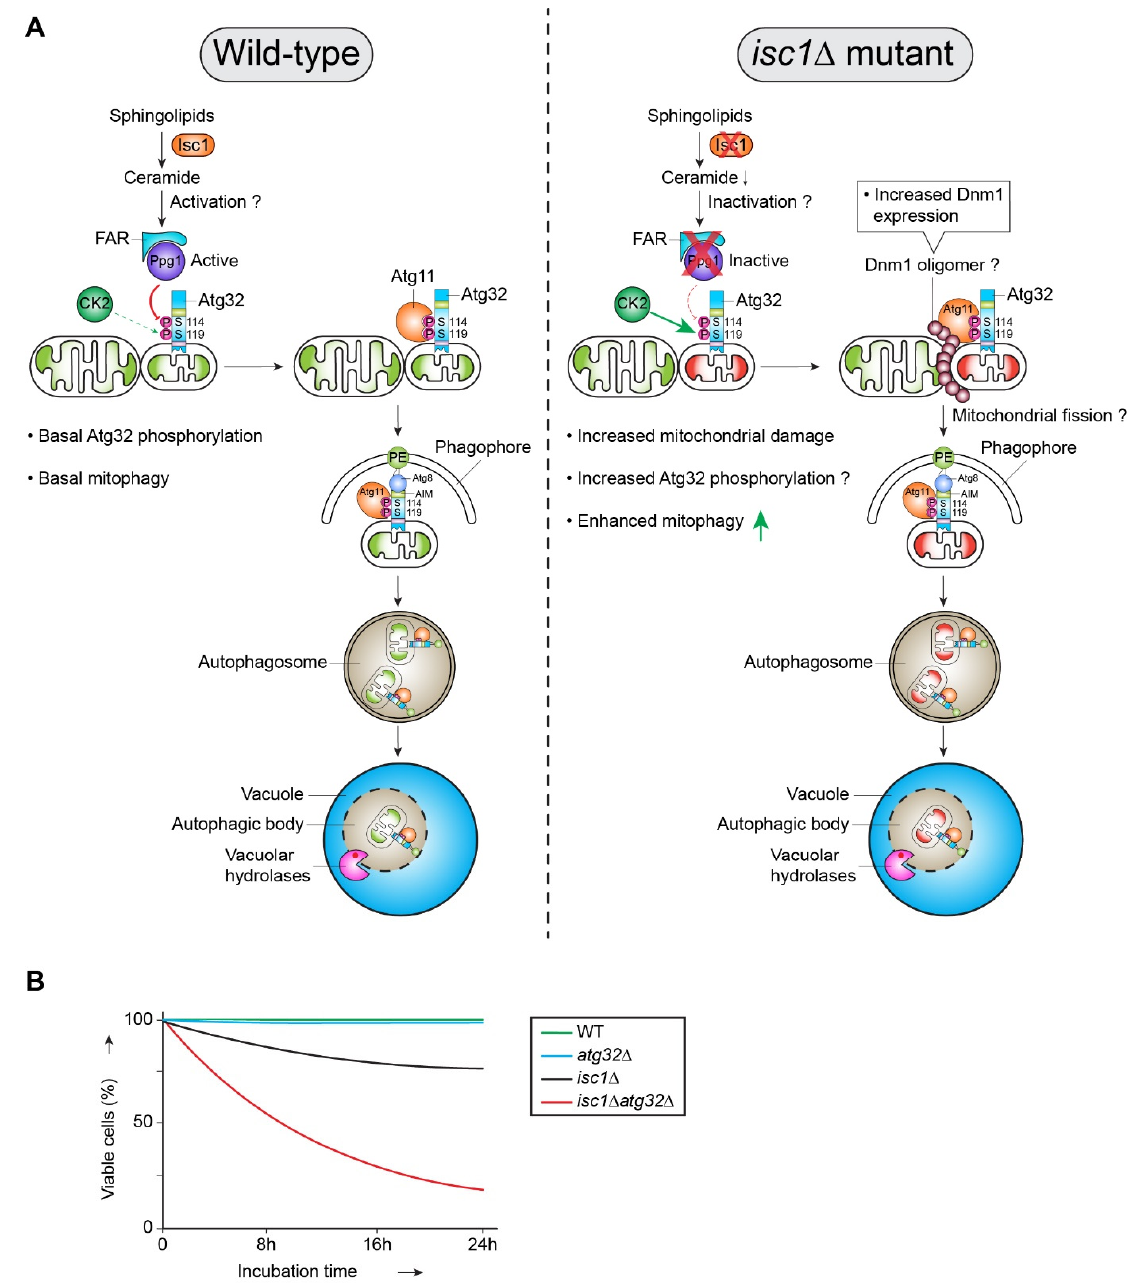
Figure 3. Interplay of ceramide synthesis, mitochondrial damage, and mitophagy in baker’s yeast. ( A ) . Regulation of Atg32-dependent mitophagy in the wild type (WT) and isc1 ∆ mutant strains. S. cerevisiae WT cells, when grown over time on non-fermentable carbon sources, maintain a basal level of mitophagy limiting excessive mitophagy. This apparently depends on the recruitment of Isc1 to mitochondria that catalyzes ceramide synthesis from sphingolipids. Mitochondrial ceramides, in turn, may activate mitochondrial localized protein phosphatase Ppg1, thus counteracting CK2-mediated phosphorylation of Atg32 and limiting excessive mitophagy. The isc1 ∆ cells show mitochondrial damage and fragmentation linked to increased protein expression of Dnm1. The isc1 ∆ mutant cells show enhanced Atg32-mediated mitophagy promoting cellular viability. ( B ) Isc1 and Atg32-dependent cellular viability. The mitophagy-deficient atg32 ∆ strain does not show any defect in the cell growth and viability. The ceramide-deficient isc1 ∆ strain can still maintain cell viability ( ∼ 80% of the wild-type level) by enhancing mitophagy, which acts as a protective mechanism here. However, additional deletion of ATG32 in isc1 ∆ cells (i.e., isc1 ∆ atg32 ∆ double mutant) drastically reduces cell survival as Isc1-dependent enhancement of mitophagy cannot operate in the absence of